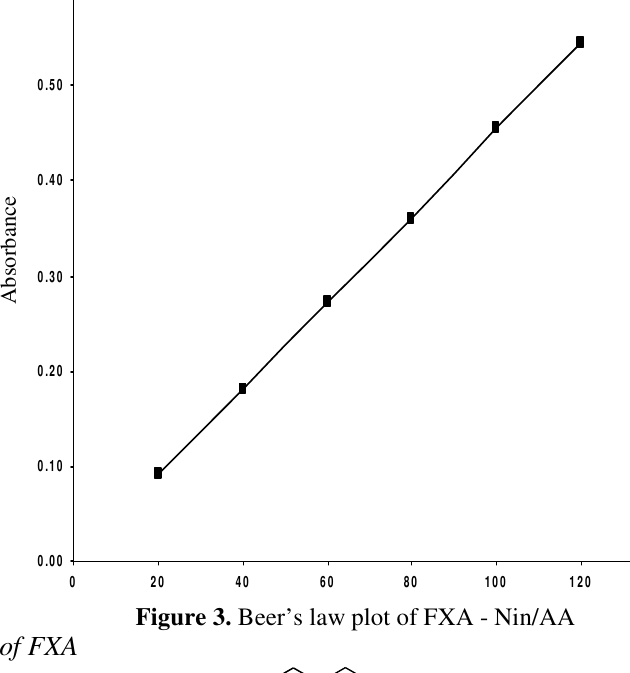
Figure 3. Beer’s law plot of FXA -